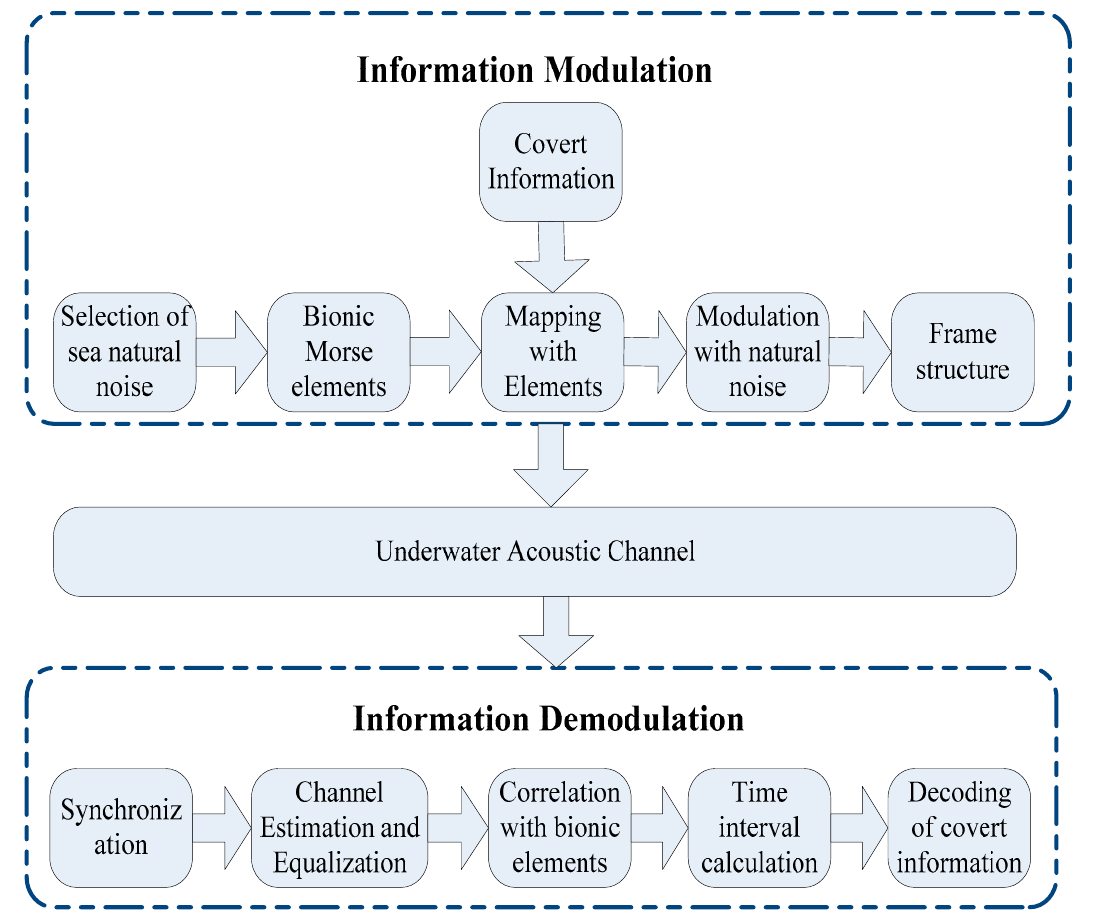
Figure 2. The process of bionic Morse coding mimicking sea natural noise.